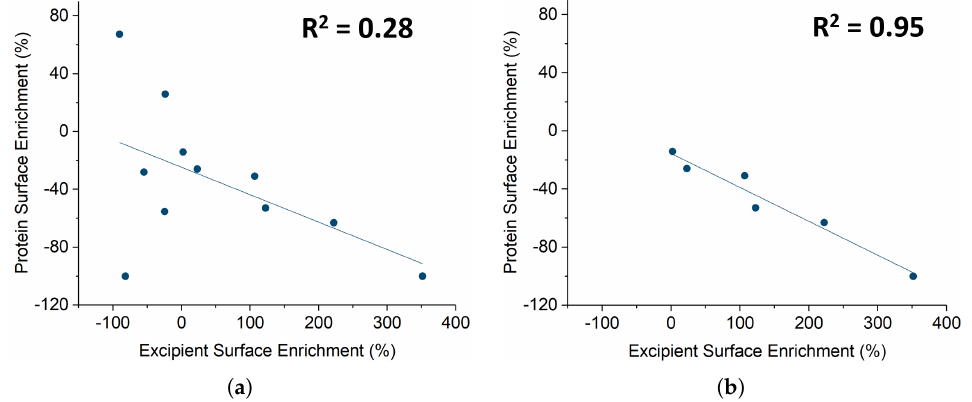
Figure 8. Preferential adsorption of protein on particle surface is curbed by competitive adsorption from excipient. Two samples (7-0[med-NH2] and 4-1[med-OH]) were statistically eliminated by the Grubbs outlier test [23]. ( a ) Excipient vs. protein preferential adsorption for samples with excipient enriched and depleted surfaces. ( b ) Excipient vs. protein surface preferential adsorption for samples with excipient enriched surfaces